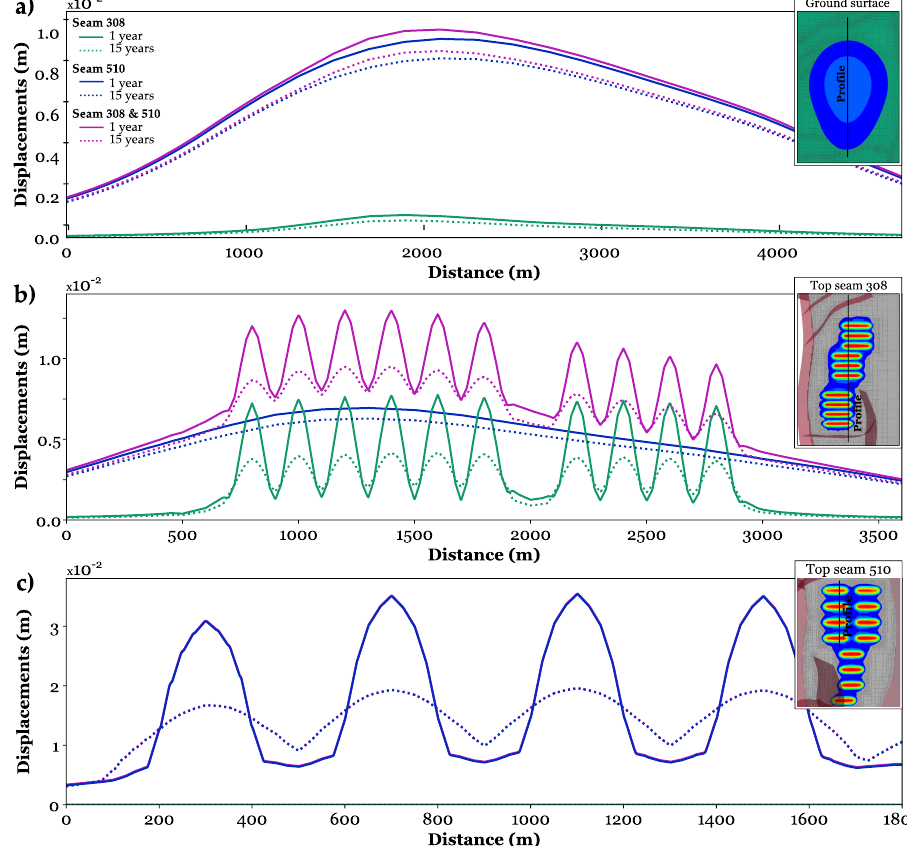
Figure 8. Vertical displacements ( a ) at the ground surface, ( b ) the top of coal seam 308, and ( c ) seam 510 for a CO 2 injection into seam 308, 510 and both seams simultaneously considering the operational and post-operational